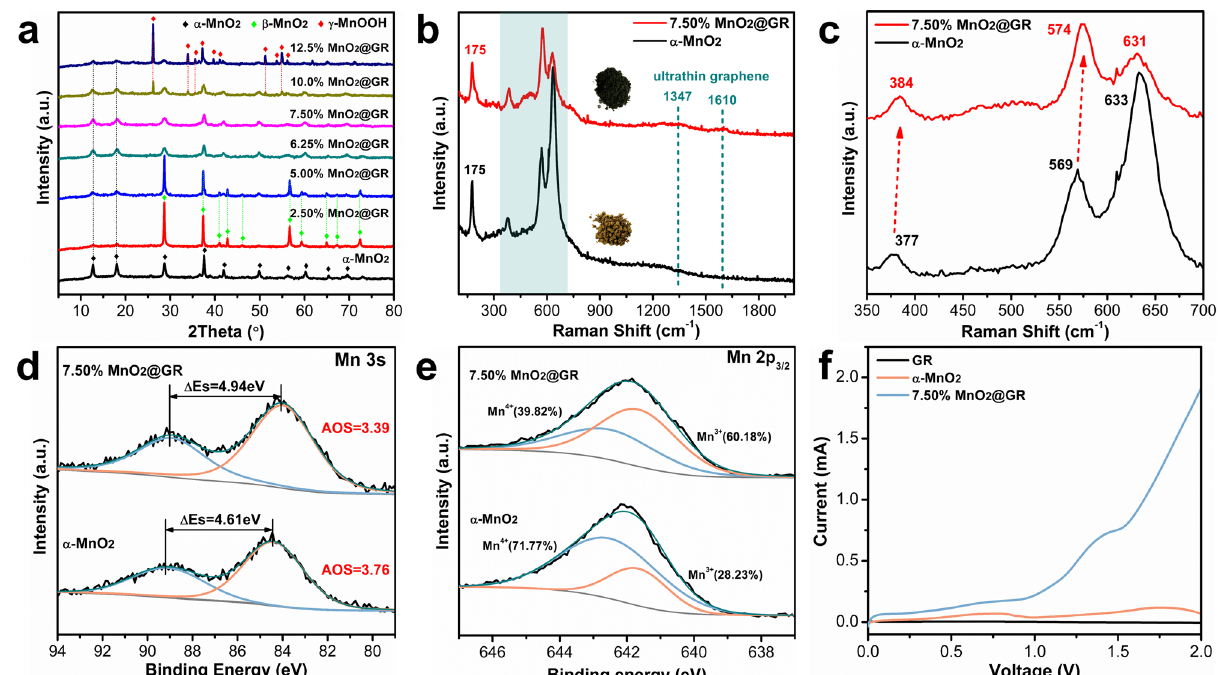
Fig. 3 Structural analysis of the 3D hierarchical MnO 2 @GR. a XRD patterns of MnO 2 @GR samples. b Raman shift of MnO 2 and 7.50% MnO 2 @GR. Insets: optical photo of the corresponding samples. c Enlarged image of Raman spectra of MnO 2 and 7.50% MnO 2 @GR. Mn 3s ( d ) and Mn 2p 3/2 ( e ) spectra of